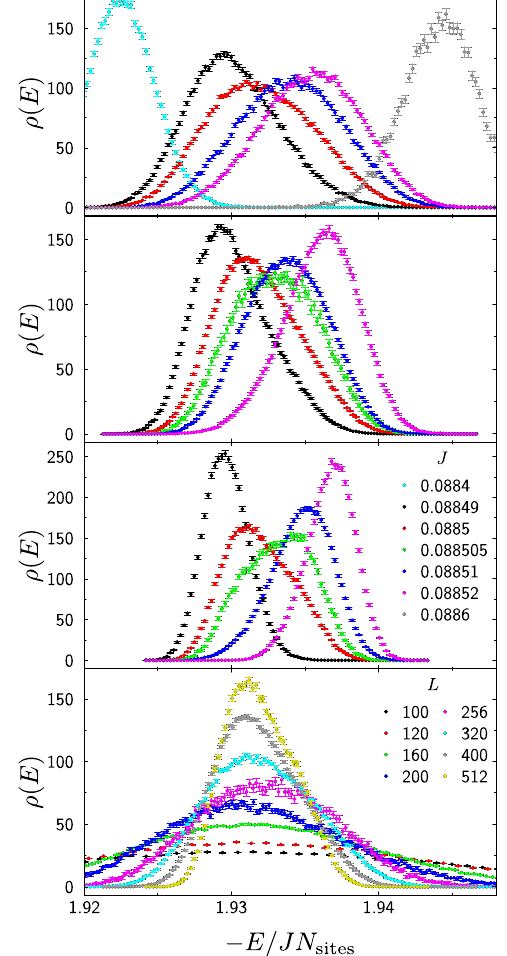
FIG. 15. First three panels starting from the top: Energy distribution functions for system sizes L ¼ 320 , 400, and 512, respectively, for various J . Bottom panel: Energy distribution for J ¼ 0 . 08850 for various L .